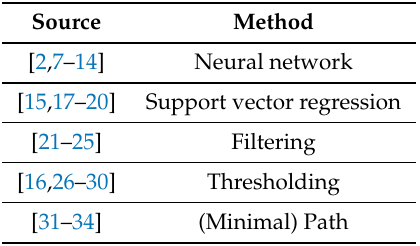
Table 2. Image-based pavement distress detection methods.